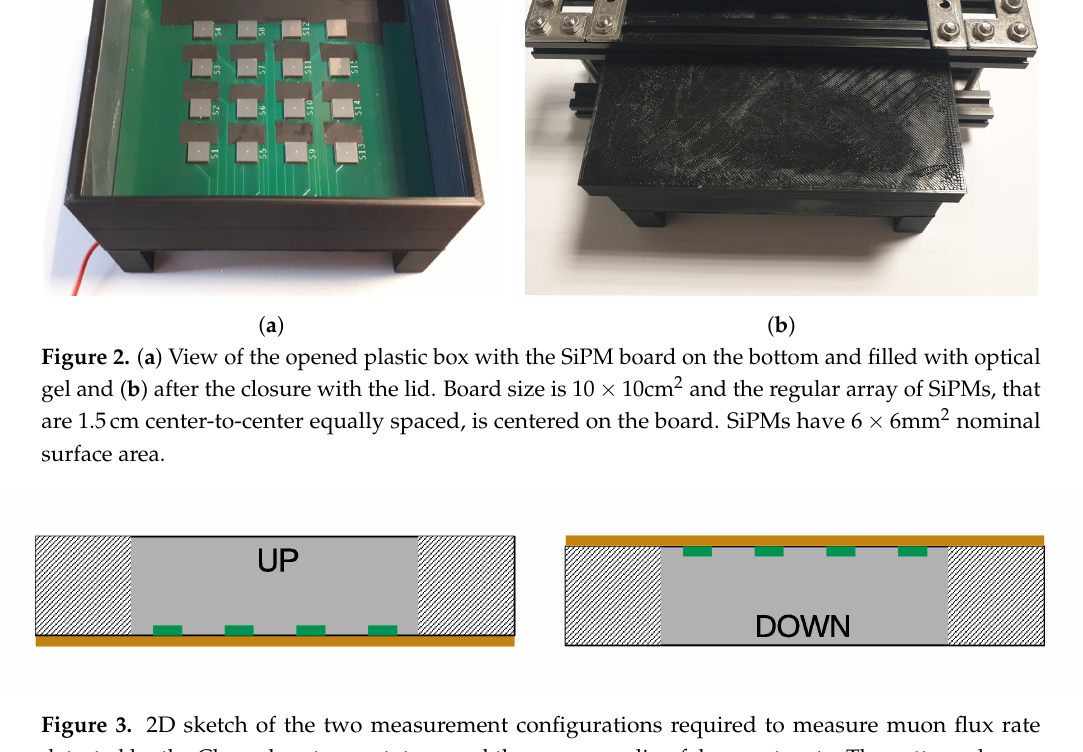
Figure 3. 2D sketch of the two measurement configurations required to measure muon flux rate detected by the Cherenkov-tag prototype and the corresponding fake events rate. The patterned areas correspond to the optical gel insensitive